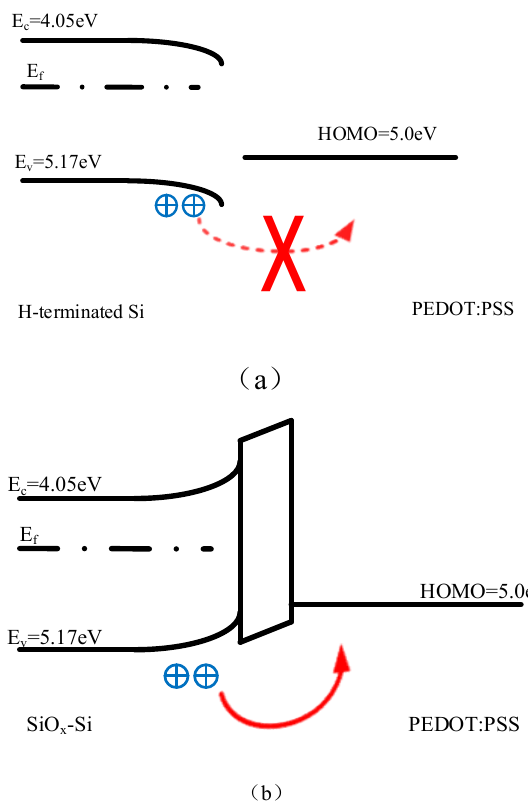
Figure 8. The energy band diagram of the ( a ) H-Si/PEDOT:PSS and ( b ) SiO x -Si/PEDOT:PSS hybrid heterojunctions.